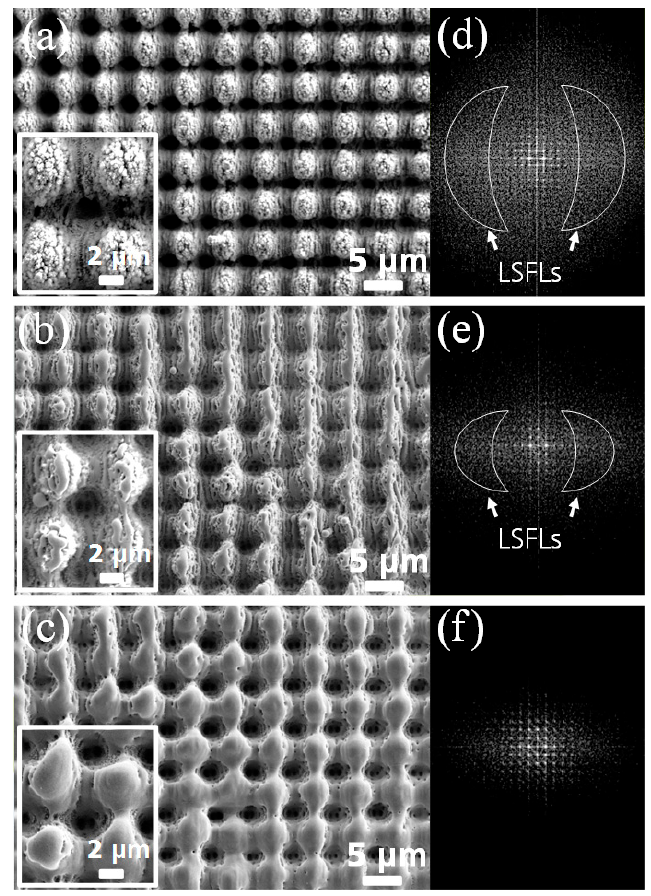
Figure 3. ( a – c ) SEM images of the stainless steel samples processed by the picosecond(ps)-DLIP technique and their 2D-fast Fourier transform (FFT) ( d – f ); ( a ) Multi-scale pillar-like structures covered by laser induced periodic surface structures (LIPSS) features and pillar-like structures after using the ns laser treatment for melting the LIPSS features at laser fluences of ( b, e ) 0.27 J/cm² and ( c, f ) 0.55 J/cm².